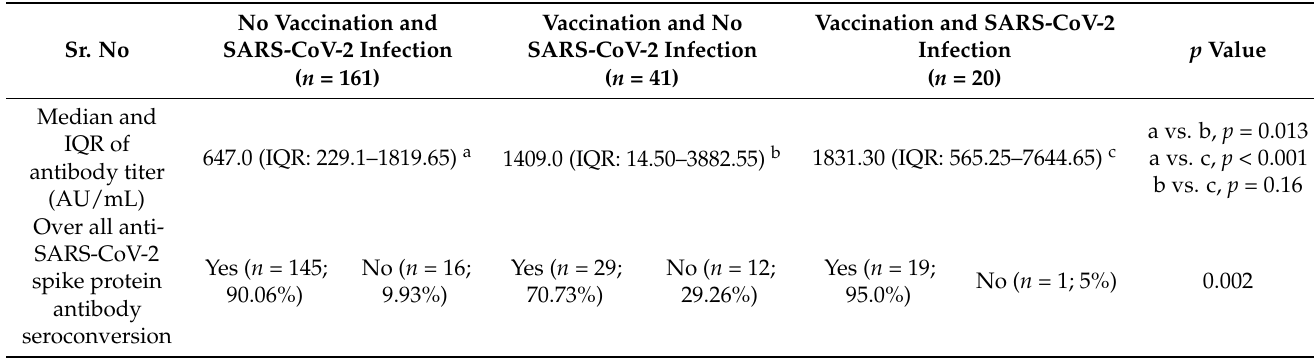
Table 2. Anti-SARS-CoV-2 spike protein antibody titer and seroconversion $ .